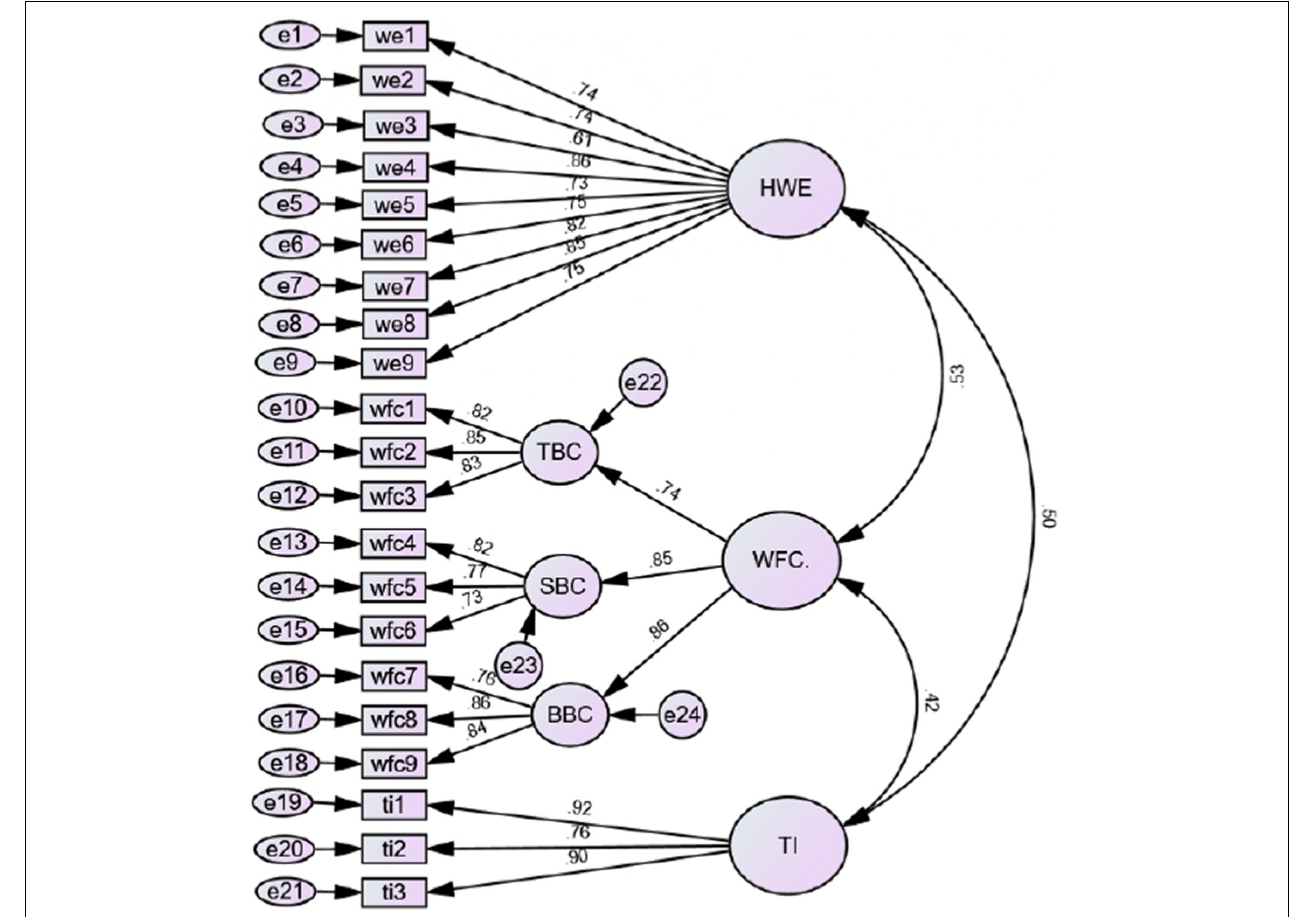
FIGURE 2 | Confirmatory factor analysis.